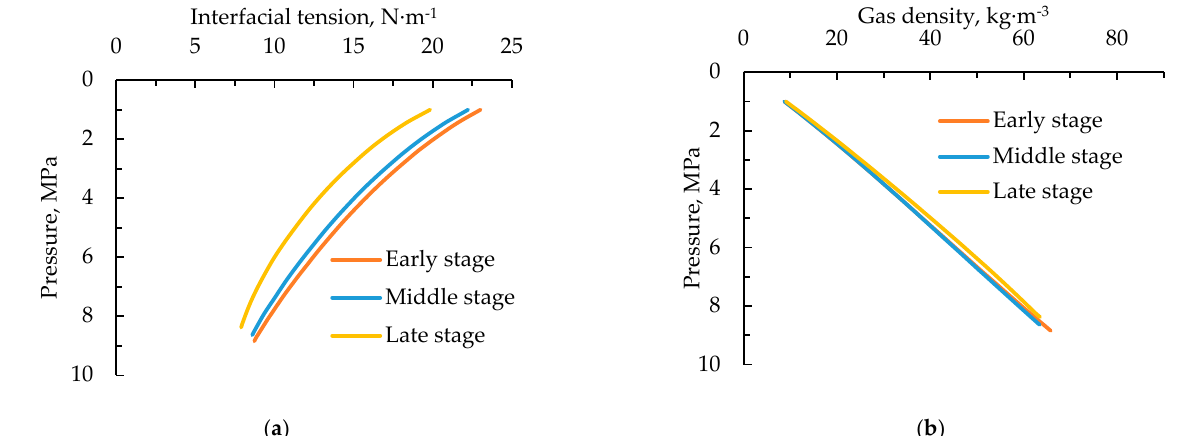
Figure 8. ( a ) The change in interfacial tension in different periods; ( b ) the change in gas density in different periods.